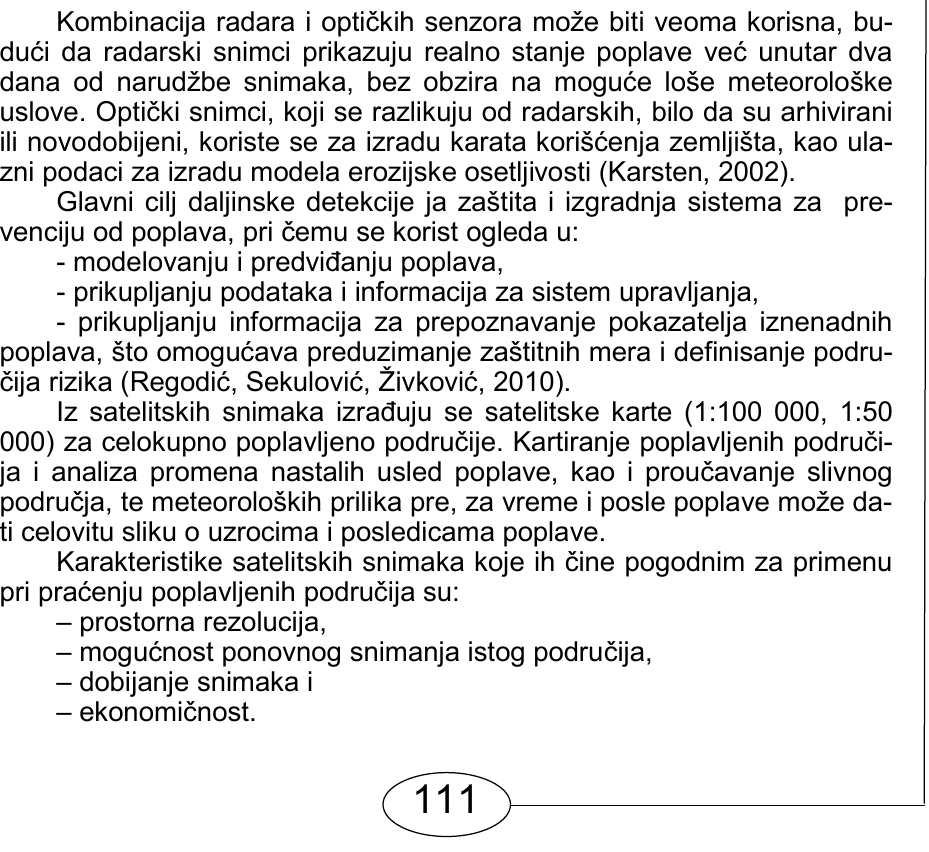
Figure 11 – The Indus River, before the